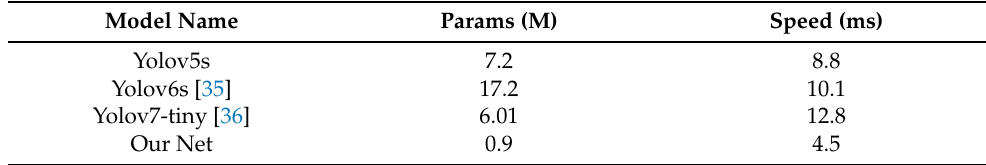
Table 2. Comparison with other